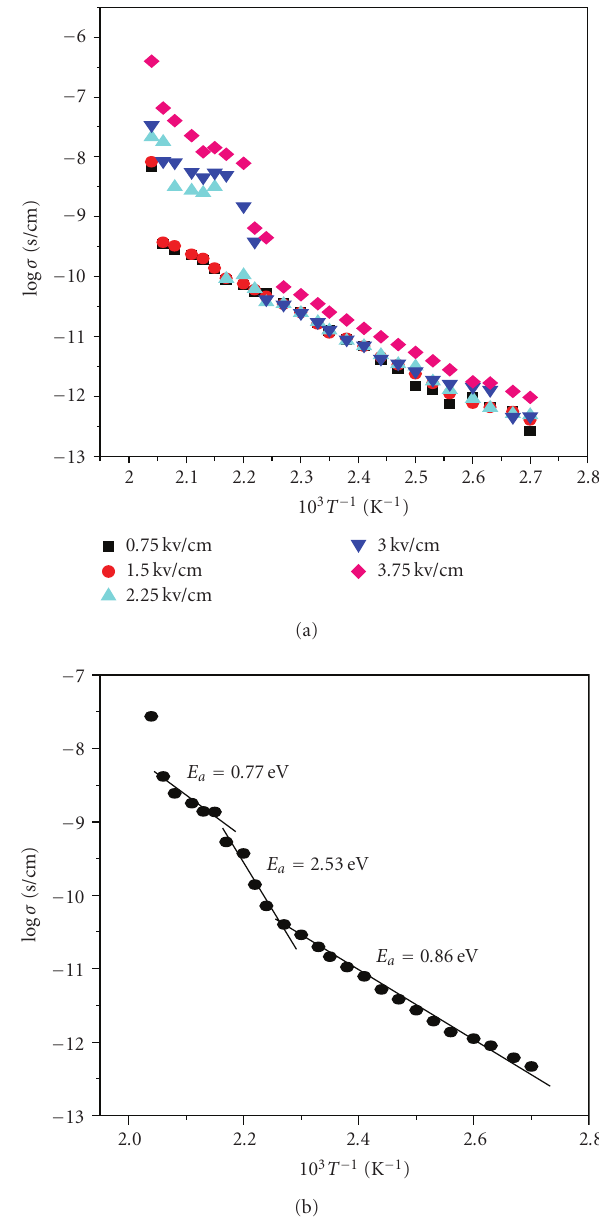
Figure 7: (a) Arrhenius plots showing Variation of σ versus 1/T at di ff erent electric fields. (b) Average Arrhenius plot showing activation energy at di ff erent temperature regions at an applied electric field of 2.25 Kv/cm